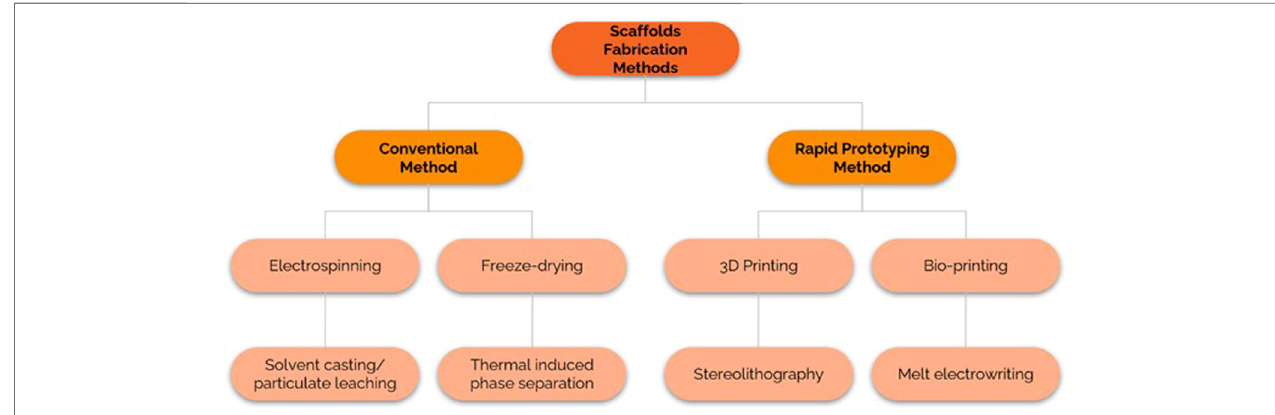
FIGURE 2 | Scaffold fabrication methods comprised of conventional and rapid prototyping methods.